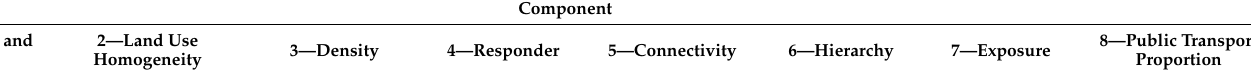
Table 2. Rotated factor loading of all candidate